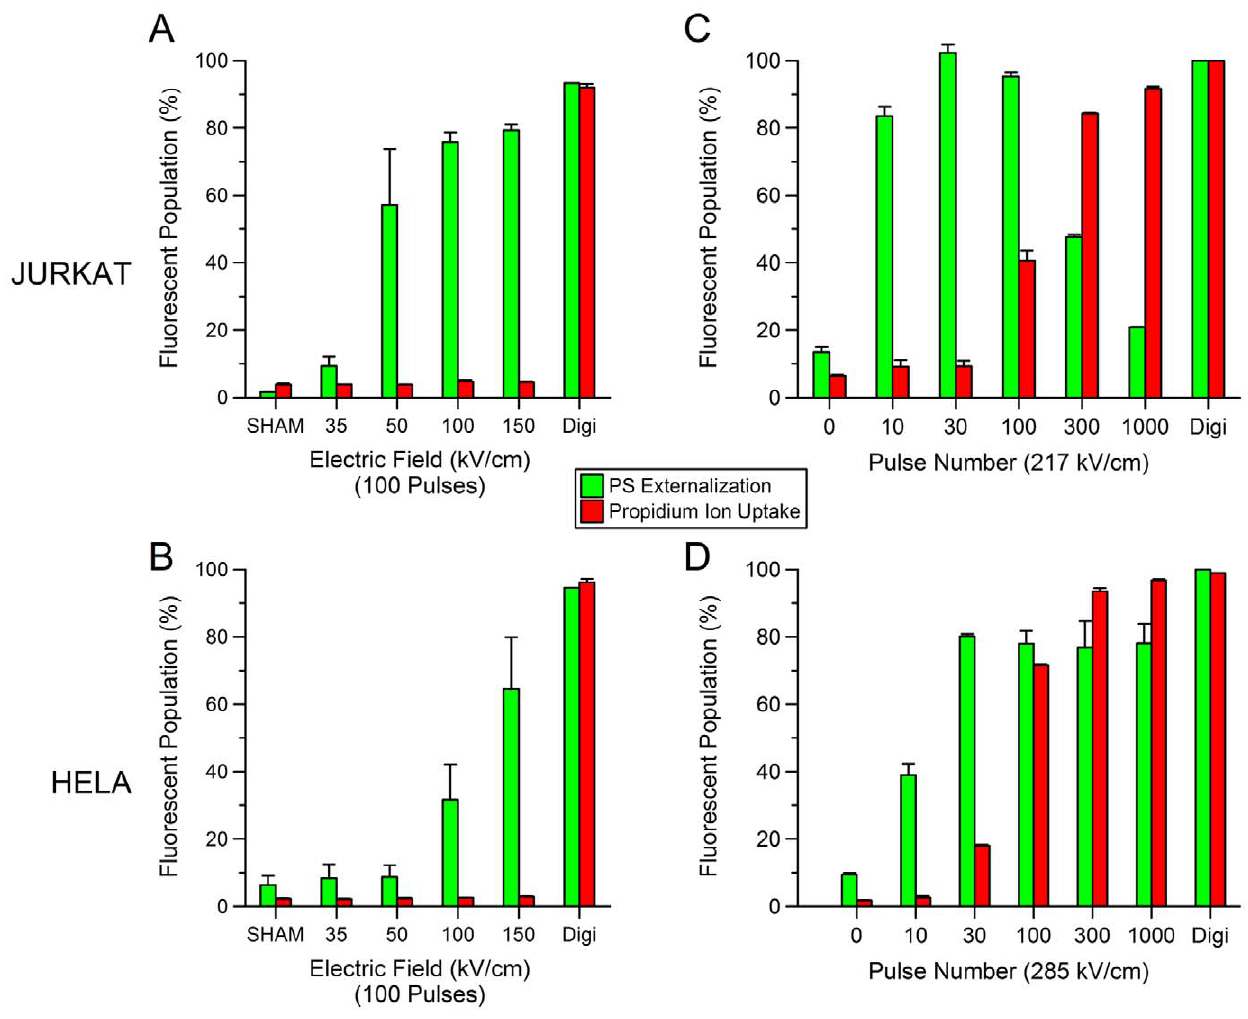
Figure 5. The effect of the E-field and pulse number on USEP-induced externalization of phosphatidylserine (PS) and uptake of propidium ions (Pr). PS and Pr fluorescent expression for Jurkat (A,C) and HeLa (B,D) exposed to increasing electric fields between 0–150 kV/cm at 100 pulses per exposure and 0.005% digitonin. Externalization of PS appears in Jurkat at lower field amplitudes than in HeLa. Both cell lines exposed to digitonin stained positive for both PS and Pr. C and D show percent of Pr positive Jurkat and HeLa after exposure to increasing number of pulses at 217 and 285 kV/cm, respectively. (mean + / 2 s.d., n=3 measurements of 25,000 cells).